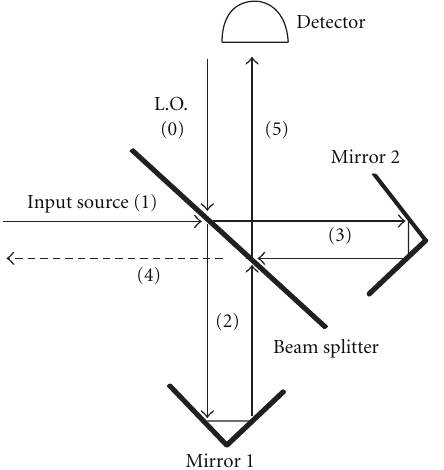
Figure 1: Schematic drawing of the MMI setup considered in this paper. The thick and diagonal line is representing a beam splitter with a transmission coe ffi cient T . The movable mirrors 1 and 2 are identical. The numbers in the parenthesis are referring to the indices used to label the mode operators of the various light beams as discussed in the main text. The signal port (1) and the local oscillator port LO (0) are prepared with various quantum states, like Fock states, coherent states, or states with random phases like thermal states. The output mode (4) will not be considered in the present